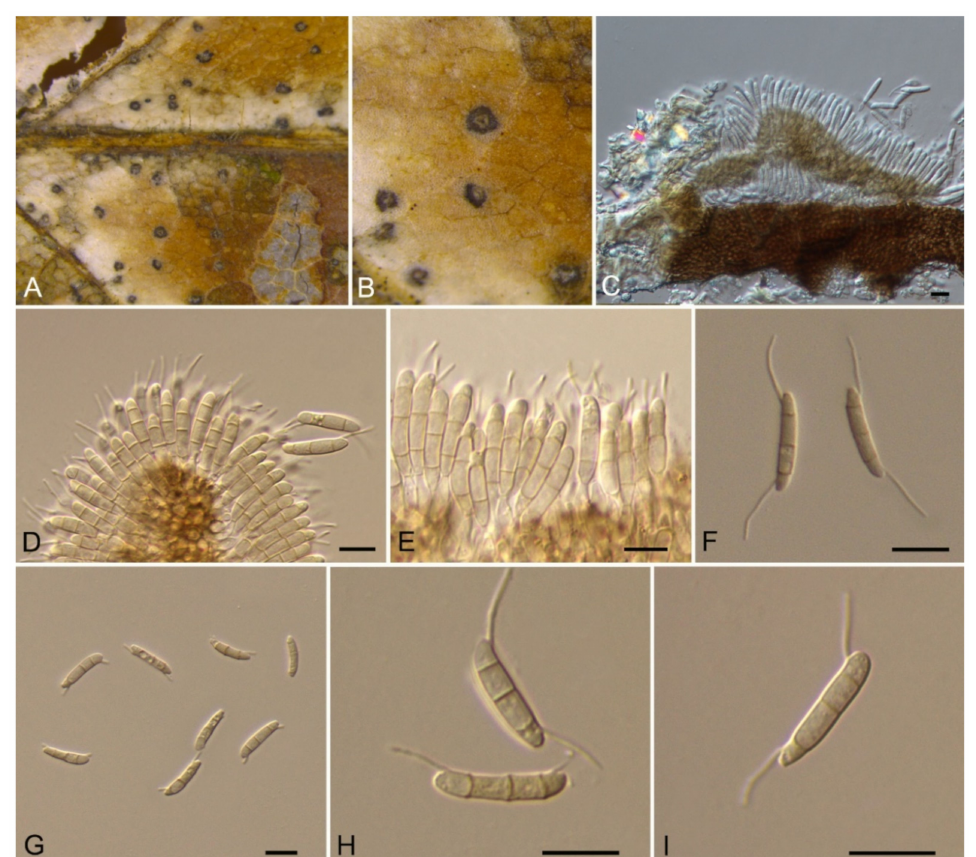
Figure 10. Discosia castaneae (BJFC-S1805). ( A , B ) Conidiomata on the diseased leaves of Castanea mollissima ; ( C ) Section through the conidioma; ( D , E ) Conidiogenous cells giving rise to conidia; ( F – I ) Conidia. Scale bars: ( C – I ) = 10 µ m. 3.9. Monochaetia (Sacc.)